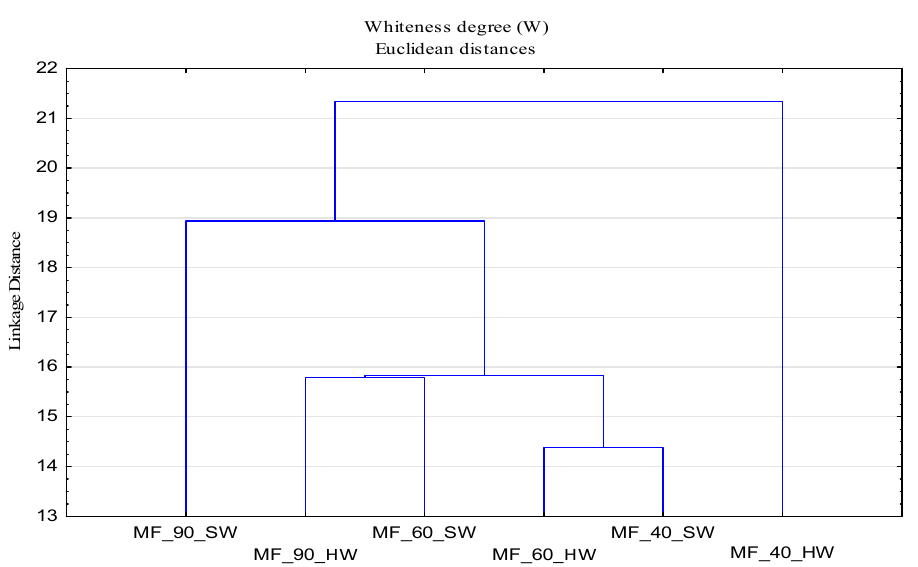
Figure 9. Dendrogram of the whiteness degree (W) as a function of temperature (T), soft (SW) and hard water (HW) .